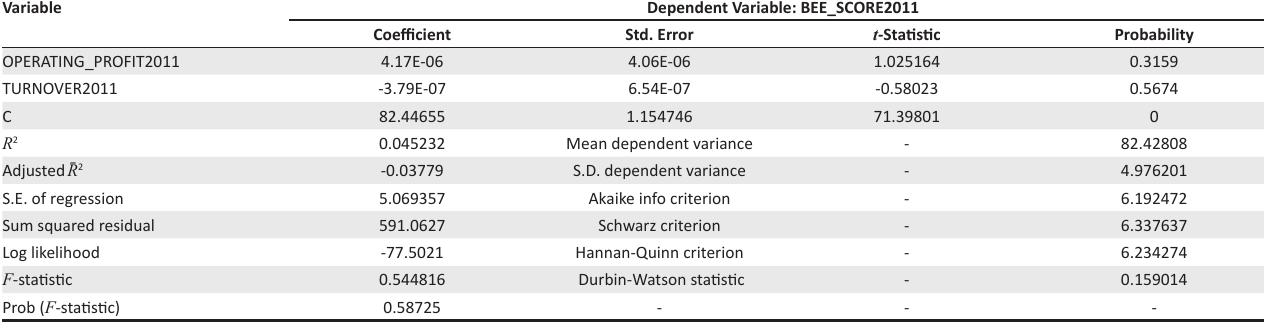
FIGURE 1: Black economic empowerment, profit and TABLE 3: Black economic empowerment, profit and turnover. Variable